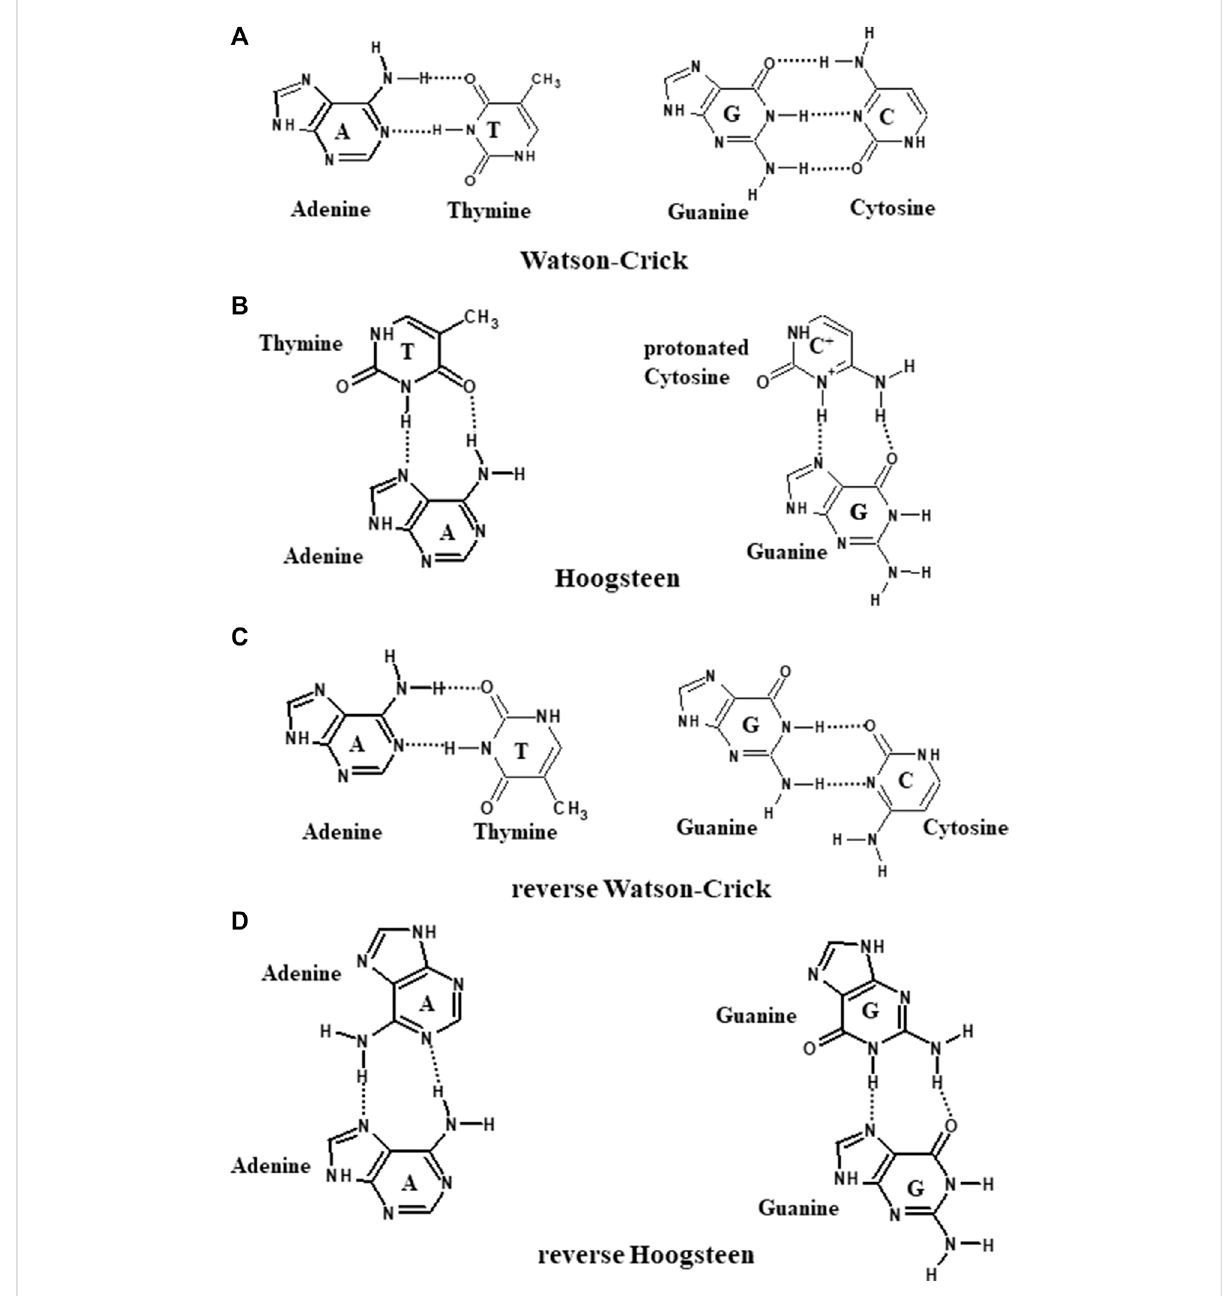
FIGURE 3 Schematic representation of (A) Watson – Crick, (B) Hoogsteen, (C) reverse Watson – Crick, and (D) reverse Hoogsteen hydrogen bonding